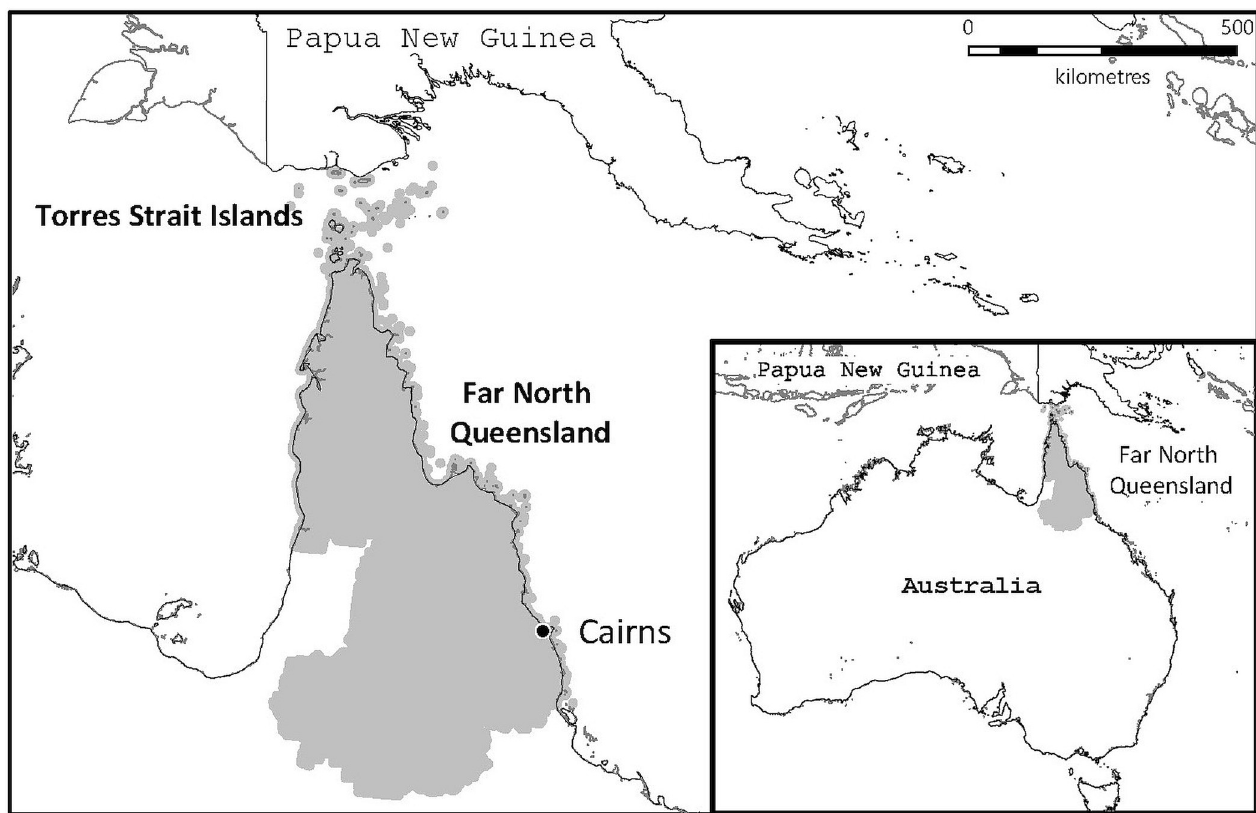
Fig 1. The study region of Far North Queensland in tropical Australia. The map was constructed using mapping software (MapInfo version 15.02, Connecticut, USA) using data provided by the State of Queensland (QSpatial). Queensland Place Names—State of Queensland (Department of